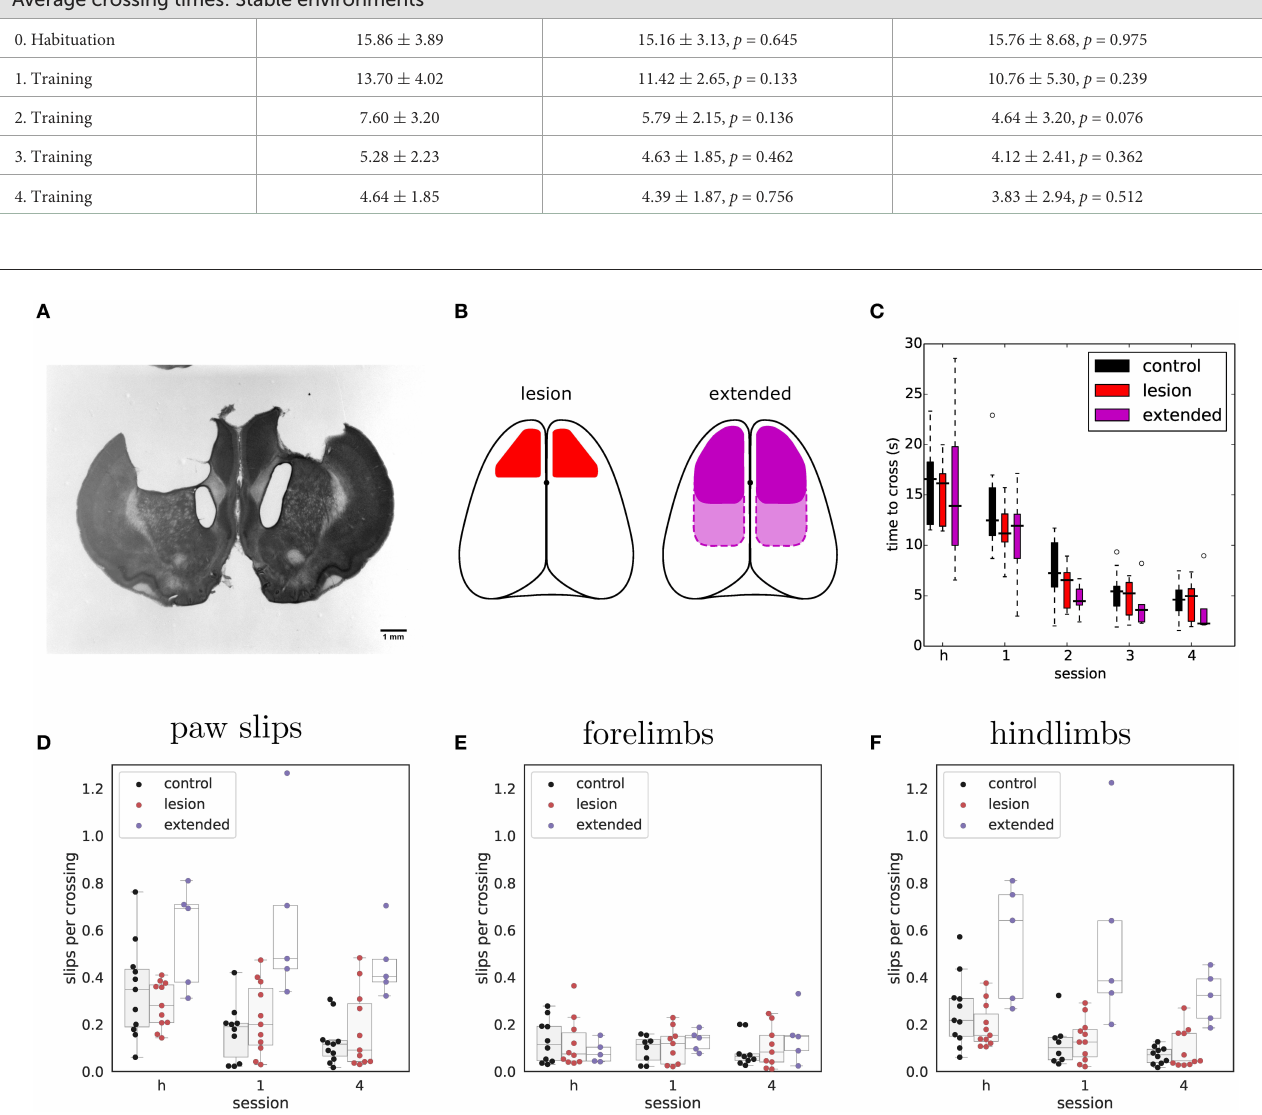
FIGURE5 Extended frontoparietal cortex lesions perform as well as control animals despite impaired hindlimb control. (A) Representative example of Nissl-stained coronal section showing bilateral aspiration lesion of forelimb sensorimotor cortex. (B) Schematic depicting targeted lesion areas in the different animal groups. Left: outline of bilateral ibotenic acid lesions to the motor cortex. Right: outline of extended bilateral frontoparietal cortex lesions. Solid outline represents frontal cortex targeted lesions and dotted outline the more extensive frontoparietal lesions. (C) Average time required to cross the obstacles during the habituation session (h) and early rewarded sessions for extended lesions ( n = 5). Performance of the other groups is shown for comparison. (D) Average number of slips per crossing in early vs. late sessions of the stable condition. (E) Same data showing only forelimb slips. (F) Same data showing only hindlimb slips.